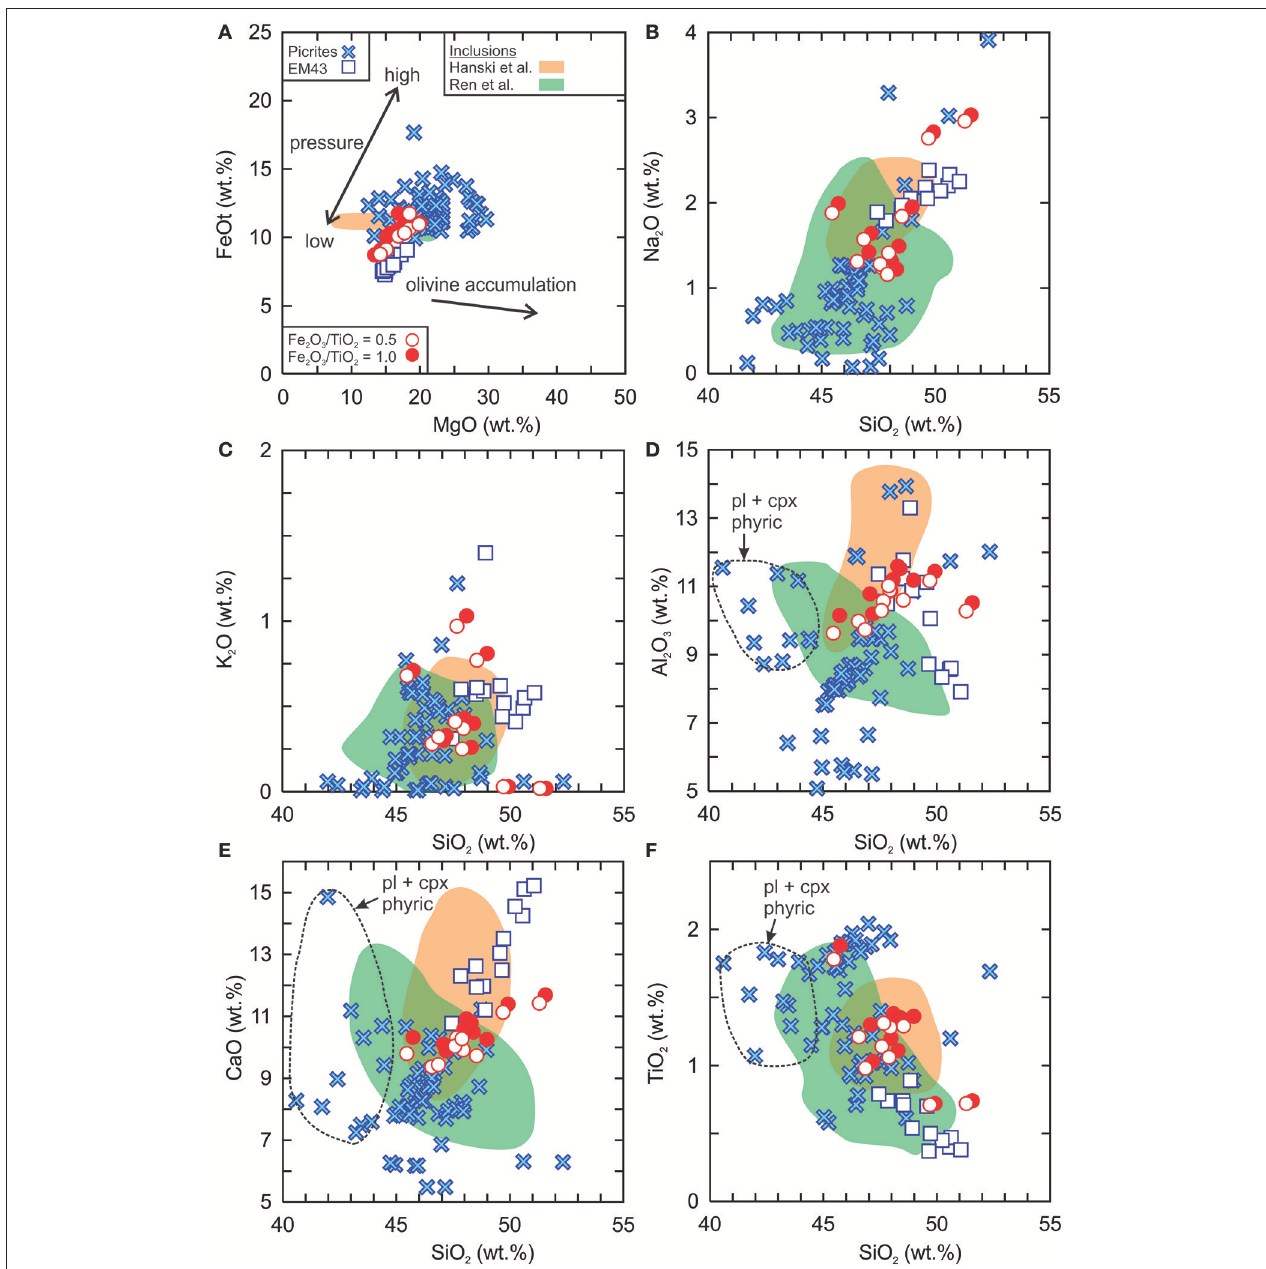
FIGURE 4 | Comparison of the calculated primary melt compositions of the low-Ti Emeishan basalt (circles) with the whole rock compositions of the low-Ti picrites (blue crosses), the primary melt composition derived from inclusions of sample EM43 (squares), and inclusions from the Dali picrites (green field = Ren et al., 2017; orange field = Hanski et al., 2010). (A) FeOt wt.% vs. MgO wt.%, (B) Na 2 O wt.% vs. SiO 2 wt.%, (C) K2O wt.% vs. SiO 2 wt.%, (D) Al 2 O 3 wt.% vs. SiO 2 wt.%, (E) CaO wt% vs. SiO 2 wt.%, and (F) TiO 2 wt.% vs. SiO 2 wt.%. The olivine accumulation and relative pressure arrows are taken from Arndt (2003). The low-Ti picrite data are from Kamenetsky et al. (2012); the EM43 (low-Ti picrite) and Dali picrite inclusions are from Ren et al. (2017). The picrites reported from Muli are plagioclase (pl) and clinopyroxene (cpx) phyric (Li et al., 2010). All data are normalized to